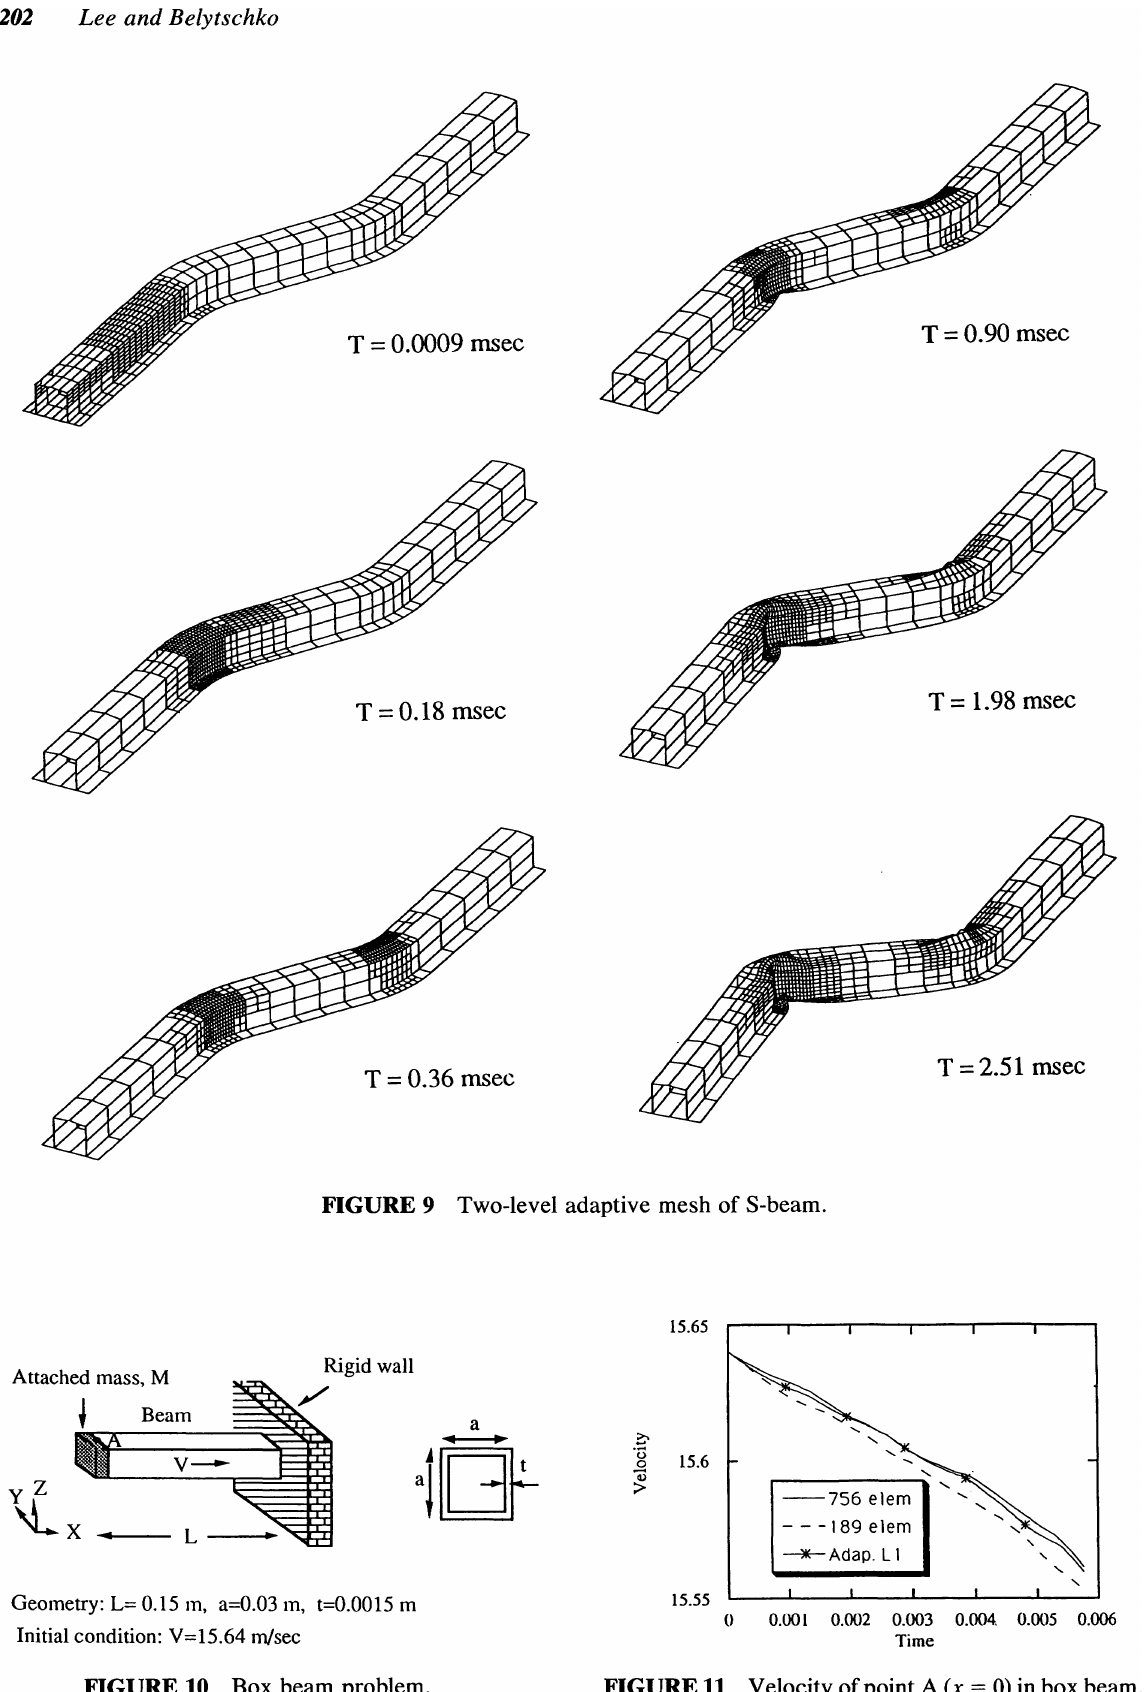
FIGURE 10 Box beam problem. FIGURE 11 Velocity of point A (x = 0) in box